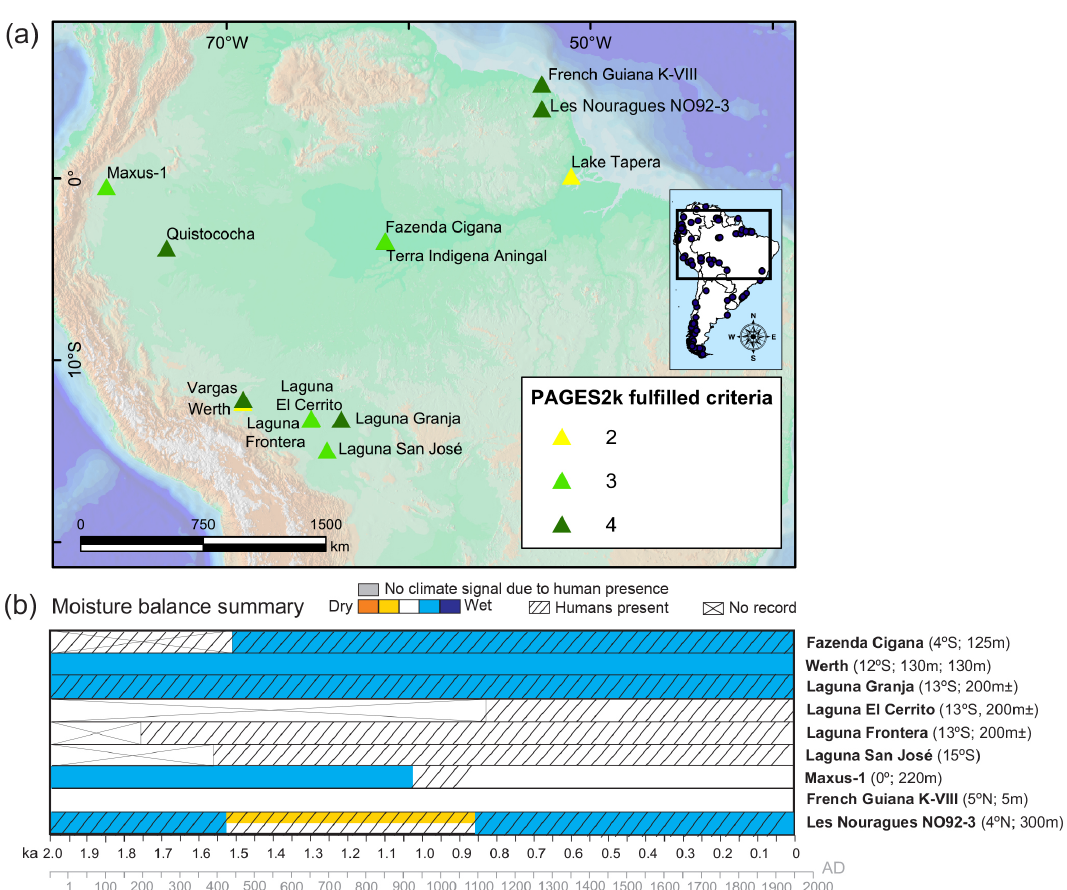
Figure 10. Panel (a) : map showing the pollen records discussed in the lowland Amazon basin and the number of PAGES-2k criteria these records fulfill. Panel (b) : summary of moisture balance and temperature including human interference for the pollen records discussed. Not all records are suitable to derive both a moisture and a temperature signal. Climate and human presence are shown overlapping when the pollen record is not conclusive regarding the derived signal. Records fulfilling one or two criteria indicated by star; m ± : ma.s.l. based on